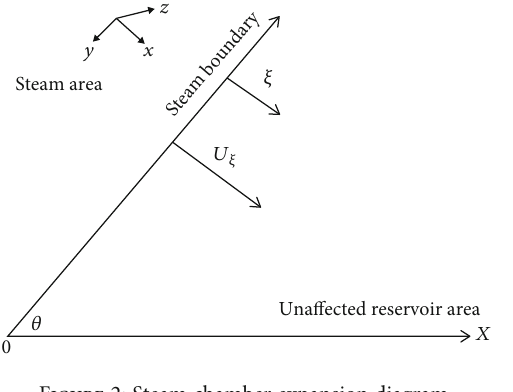
Figure 2: Steam chamber expansion